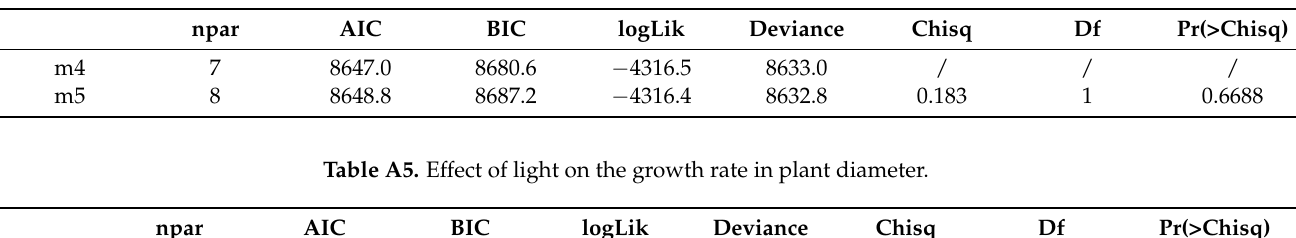
Table A4. Effect of light on the growth rate in plant height.